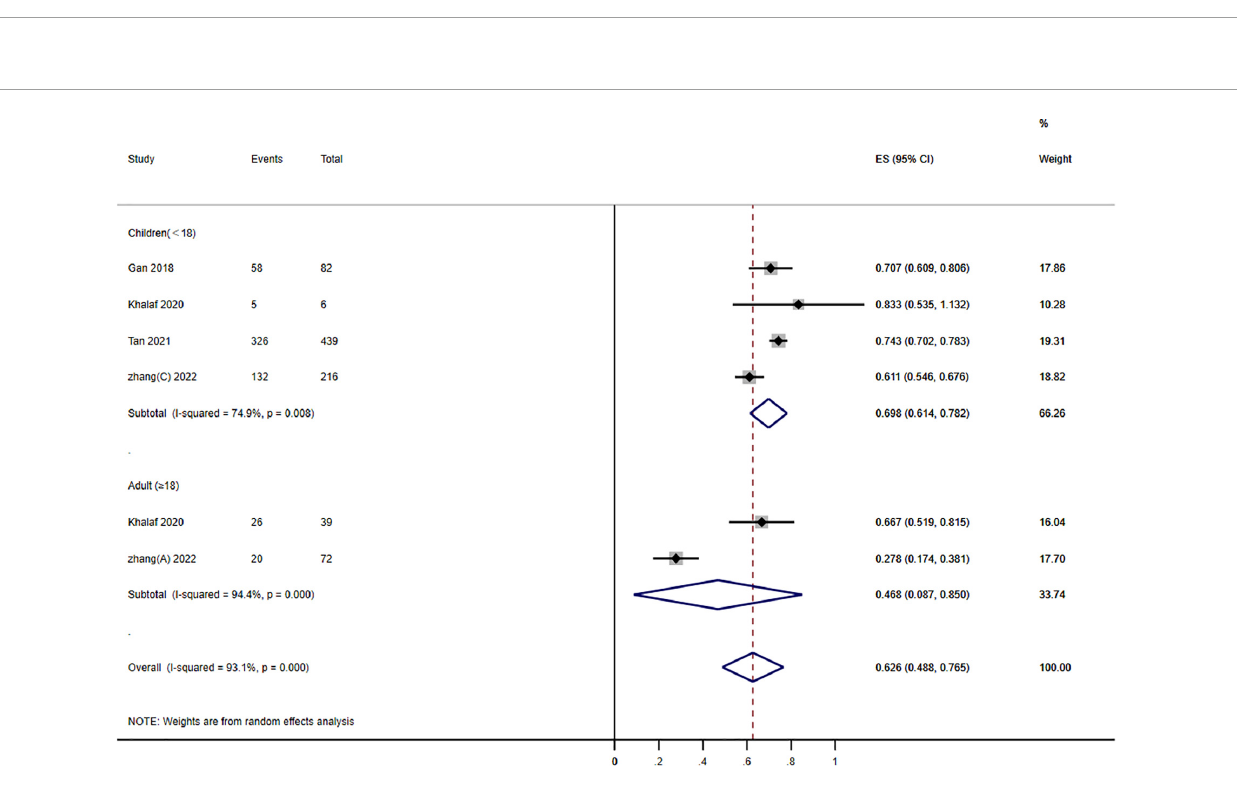
FIGURE4 Forest plot of the effects of photodynamic therapy (PDT) according to different age groups of port wine stains (PWS) ( ≥ 60% improvement). Weights are from random effects analysis.